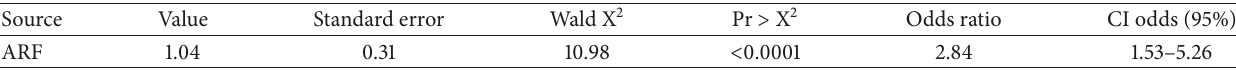
Table 3: Parameters obtained for the model created through the application of logistic regression in order to find the factors that predispose to Atrial